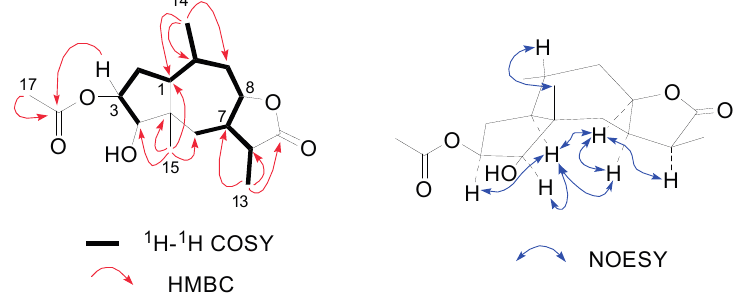
Figure 2. Key 1 H- 1 H COSY, HMBC and NOESY correlations of 1